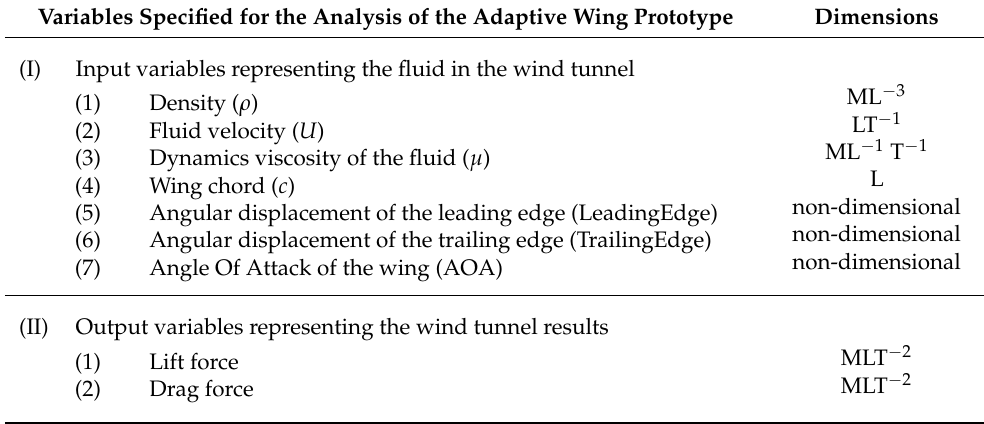
Table 3. Variables for the lift and drag analysis.